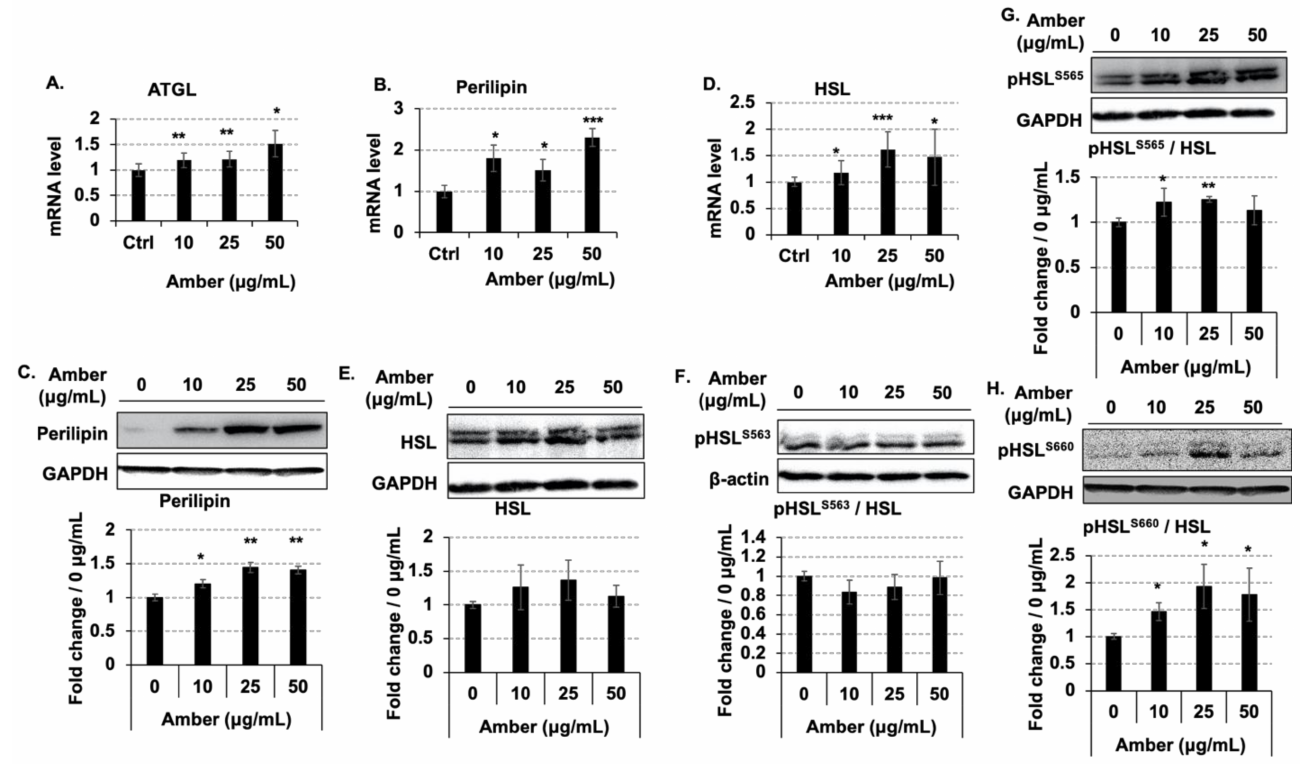
Figure 3. Effects of amber extract on lipolysis-related gene expression. Mature 3T3-L1 cells treated with amber extract (0, 10, 25, and 50 µ g/mL) were collected after 24 h, in which mRNA levels were measured by RT-PCR, and protein levels were detected by western blotting. Expression of ( A ) adipose triglyceride lipase (ATGL), ( B ) perilipin, and ( D ) hormone-sensitive lipase (HSL) at the mRNA level was detected by RT-PCR; the data were directly obtained from the machine. Western blot images of ( C ) perilipin, ( E ) HSL, ( F ) pHSL S563 , ( G ) pHSL S565 , and ( H ) pHSL S660 analyzed by ImageJ. Statistical analysis of western blot bar graphs was performed in three independent experiments. The results are expressed as the mean ± SD; n = 3; * p < 0.05, ** p < 0.01, *** p < 0.001 vs. 0 µ